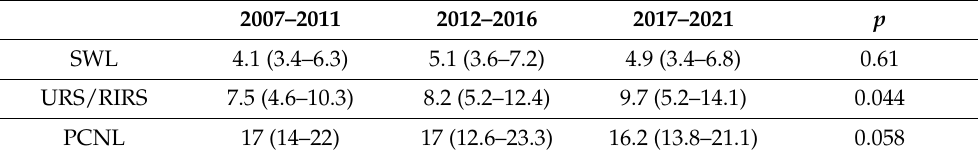
Table 1. Stone size (mm, median